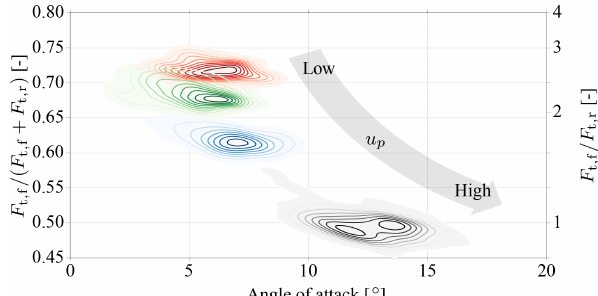
Figure 7. Distribution of tensile forces in the bridle line system from low to high power setting (red, green, blue, black) measured for a commercially available LEI Hydra V5 kite with 14m 2 wing surface area by Genetrix Kiteboarding (adapted from van Reijen,